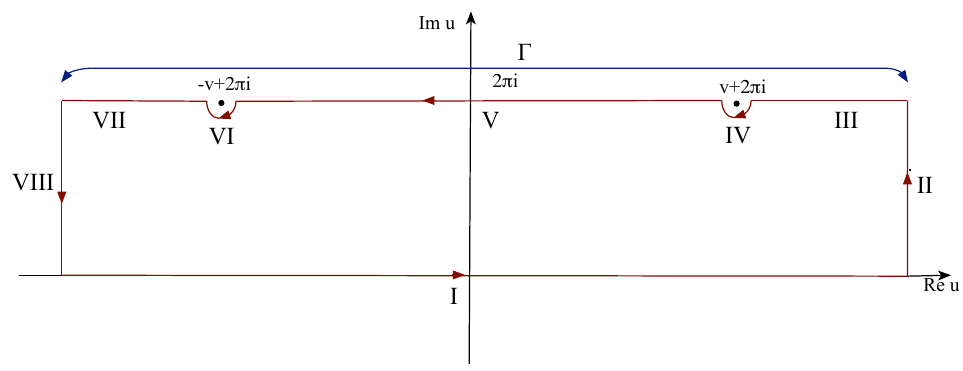
Figure 3 . The red contour C used to perform the integration over u